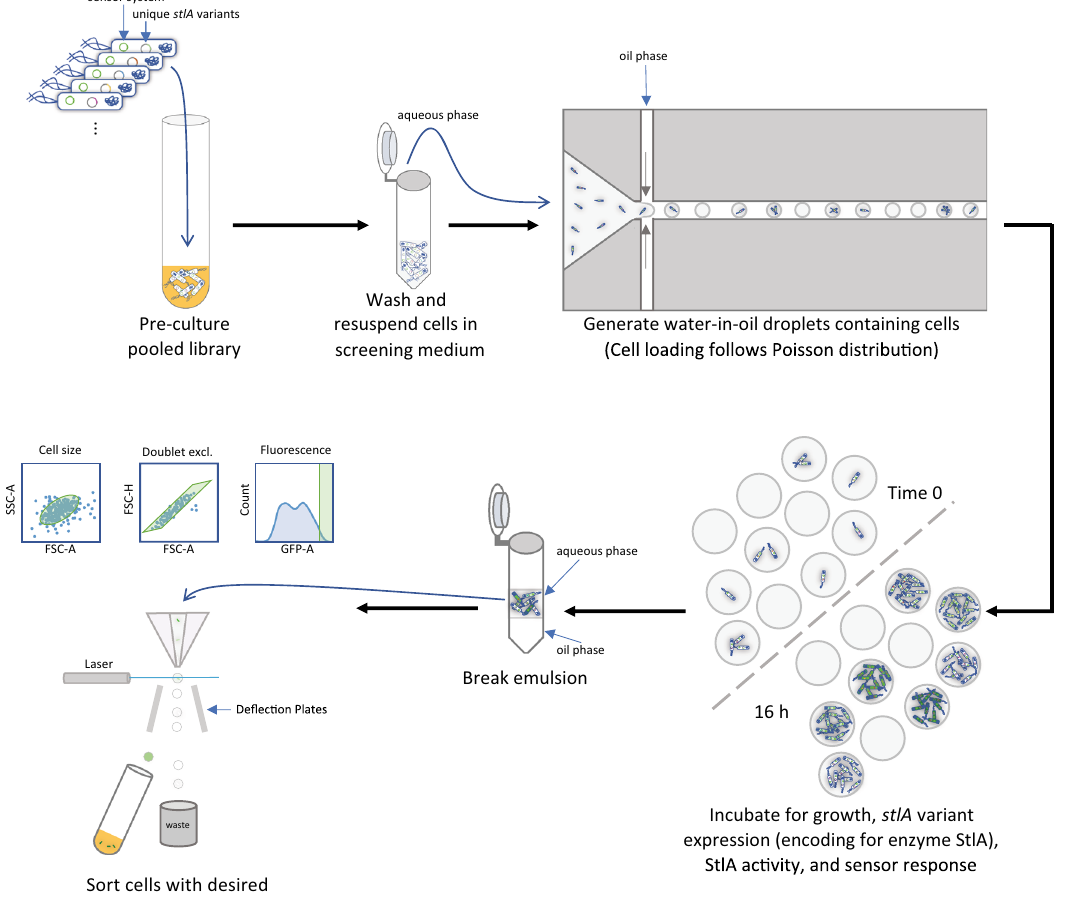
Fig. 2 Depiction of pop ‘ n ’ sort methodology. EcN cells harboring the high-copy sensor system plasmid (engineered aTF expression, with aTF-repressed gfp gene encoding for green fl uorescent protein GFP) and a library of low-copy inducible stlA variant expression plasmids were grown together within a pool; different cells in this pool contain unique stlA sequences. Following a pre-culture step in a rich medium, the cells are washed and resuspended in an adapted M9 minimal glucose medium for sensor screening, which simultaneously induces stlA expression and provides the substrate Phe. At this stage, the cells are diluted to an OD 600 that will result in ~1 cell/droplet loading. These diluted, washed cells in medium serve as the aqueous phase for droplet generation in a fl uorinated oil with fl uorosurfactant. Because cell loading follows a Poisson distribution, some droplets will be empty and some will contain multiple cells/genotypes at time 0, as shown above. The loaded droplets are incubated until saturation, ~16 h, at which point there are many cells per droplet, and these cells have produced TCA and a per cell GFP signal that is correlated with that TCA production. Since the GFP signal is associated with the cell itself, we can break the emulsions using standard techniques, then sort the cells directly on a FACS for the desired phenotype. See Methods for details on recipes, materials, and